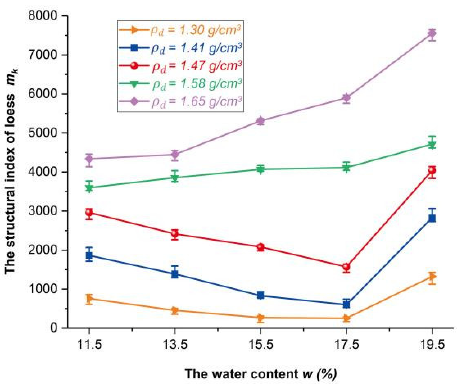
Figure 12. The quantitative index of loess structure based on air permeability.